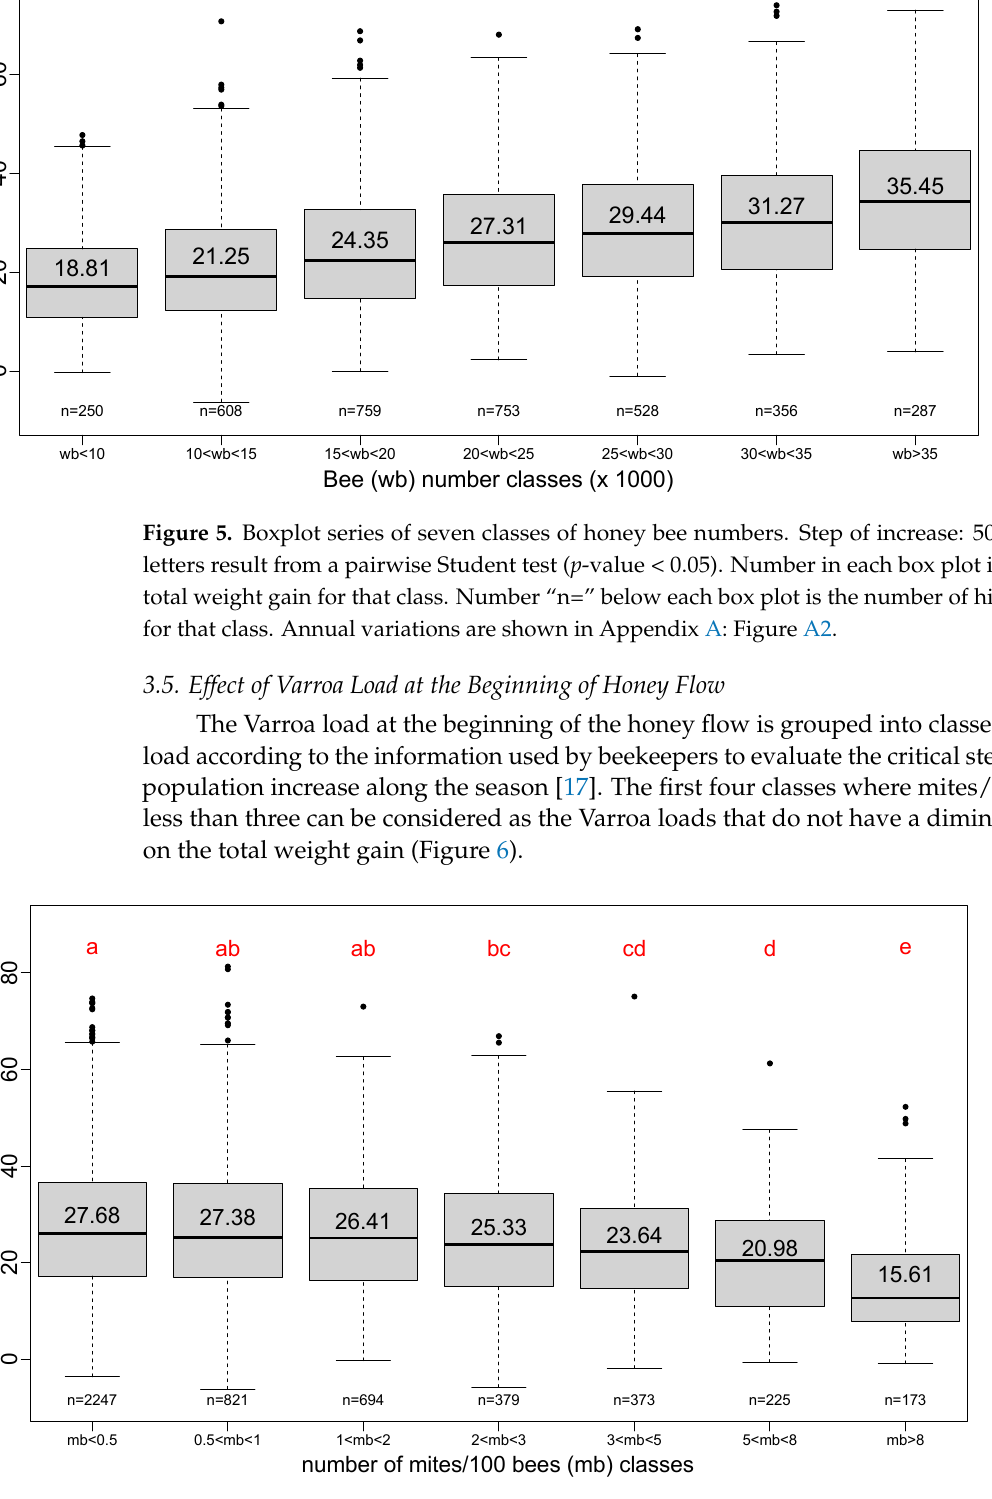
Figure 6. Boxplot series of seven classes of number of mites/100 bees. Unequal step of increase. Red letters result from a pairwise Student test ( p -value < 0.05). Number in each box plot is the average total weight gain for that class. Number “n=” below each box plot is the number of hives surveyed for that class.